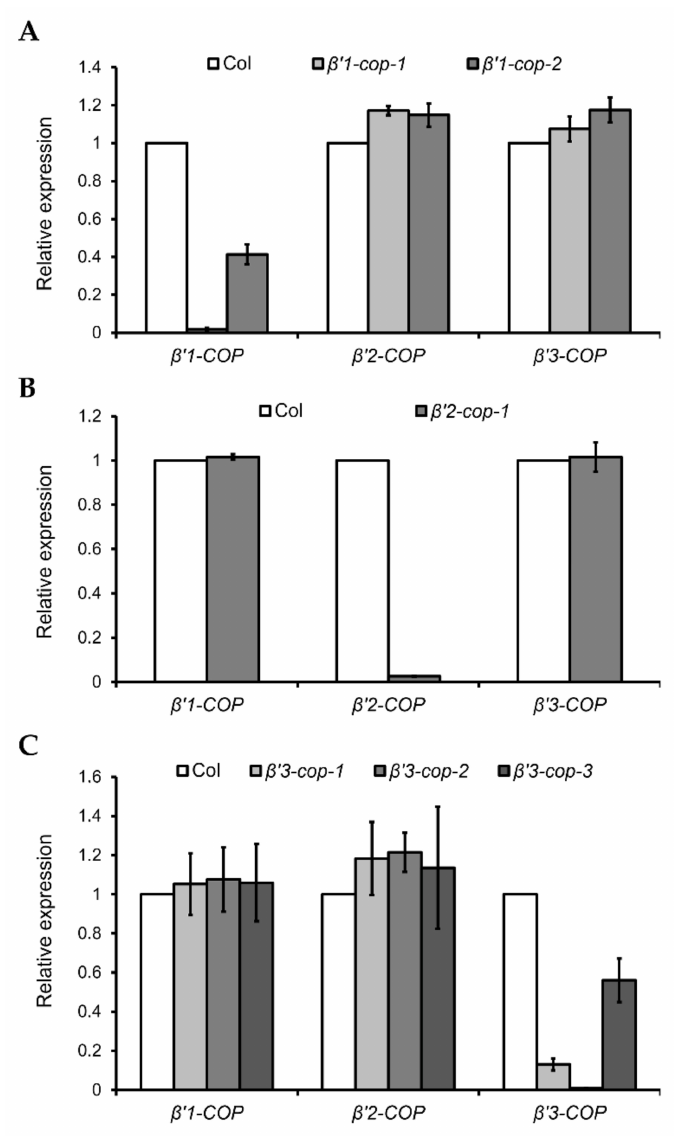
Figure 2. Relative expression levels of β ’-COP genes in β ’-cop mutants. RT–qPCR analysis was performed to characterize β ’1-cop ( A ), β ’2-cop ( B ) and β ’3-cop ( C ) mutants. Total RNA was extracted from 7-day-old seedlings of the mutants and wild type (Col-0). The mRNA was analyzed by RT–qPCR with specific primers and normalized to UBQ10 expression (Supplementary Tables S1–S3). Results are from three biological samples and three technical replicates. mRNA levels are expressed as relative expression levels and represent fold changes of mutant/wild type. Values represent mean ± s.e.m. of the three biological